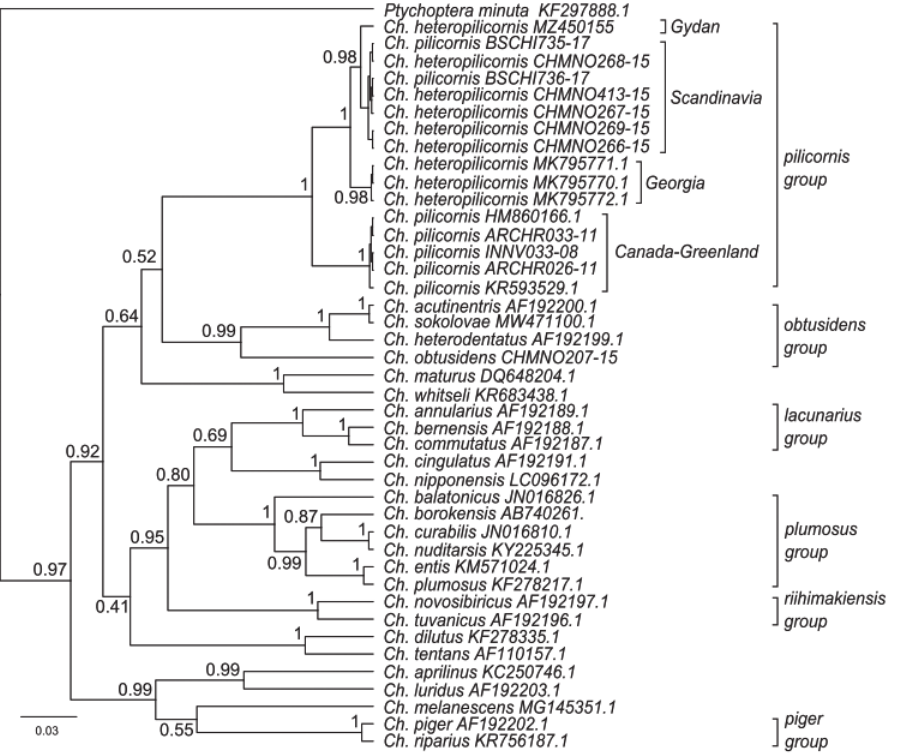
Figure 4. Bayesian tree of the analyzed samples of Chironomus spp. inferred from COI sequences. Spe- cies name, GenBank accession numbers and group name are shown to the right of the branches. Support values are given if they exceed 0.4. The numbers at the nodes indicate posterior